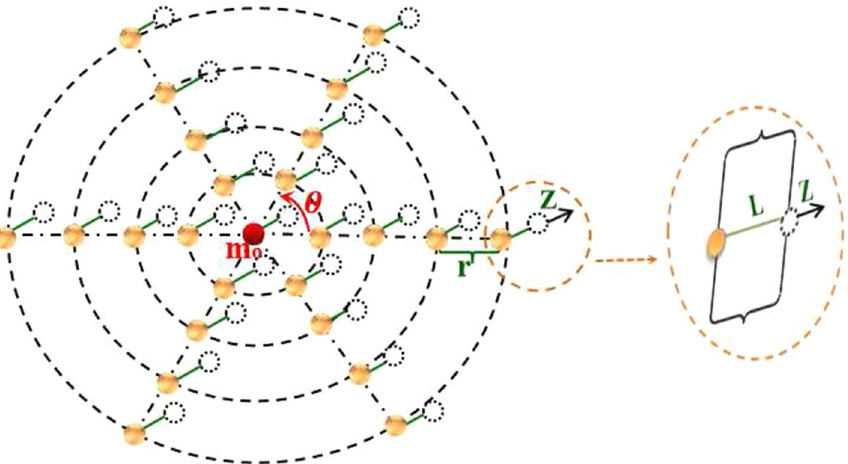
particle is in a superposition of localized states along the z -axis sepa- rated by a distance L (Among them, the right is a local enlarged view of the model). In addition, the two-dimensional ray model we present is different from the traditional star model, that is, when the number of rays x is even, the two-dimensional ray model can be symmetric or asymmetric. Therefore, as long as the distance between the adjacent particles in the first layer meets the condition that the distance is not less than r , the distance between the adjacent particles in the first layer can also be